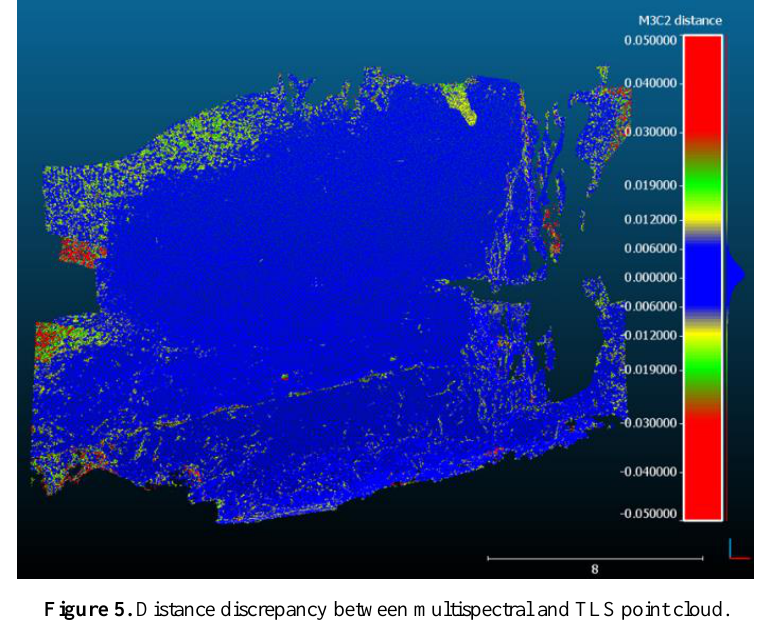
Figure 5. Distance discrepancy between multispectral and TLS point cloud.